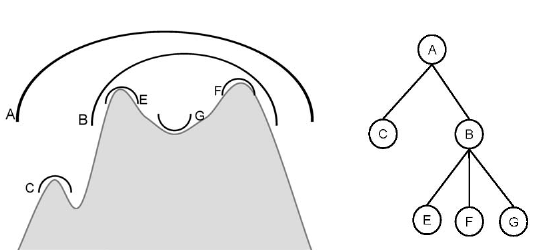
Figure 2: Terrain features and feature tree identified from Figure 1 contour tree (Zhang and Guilbert,